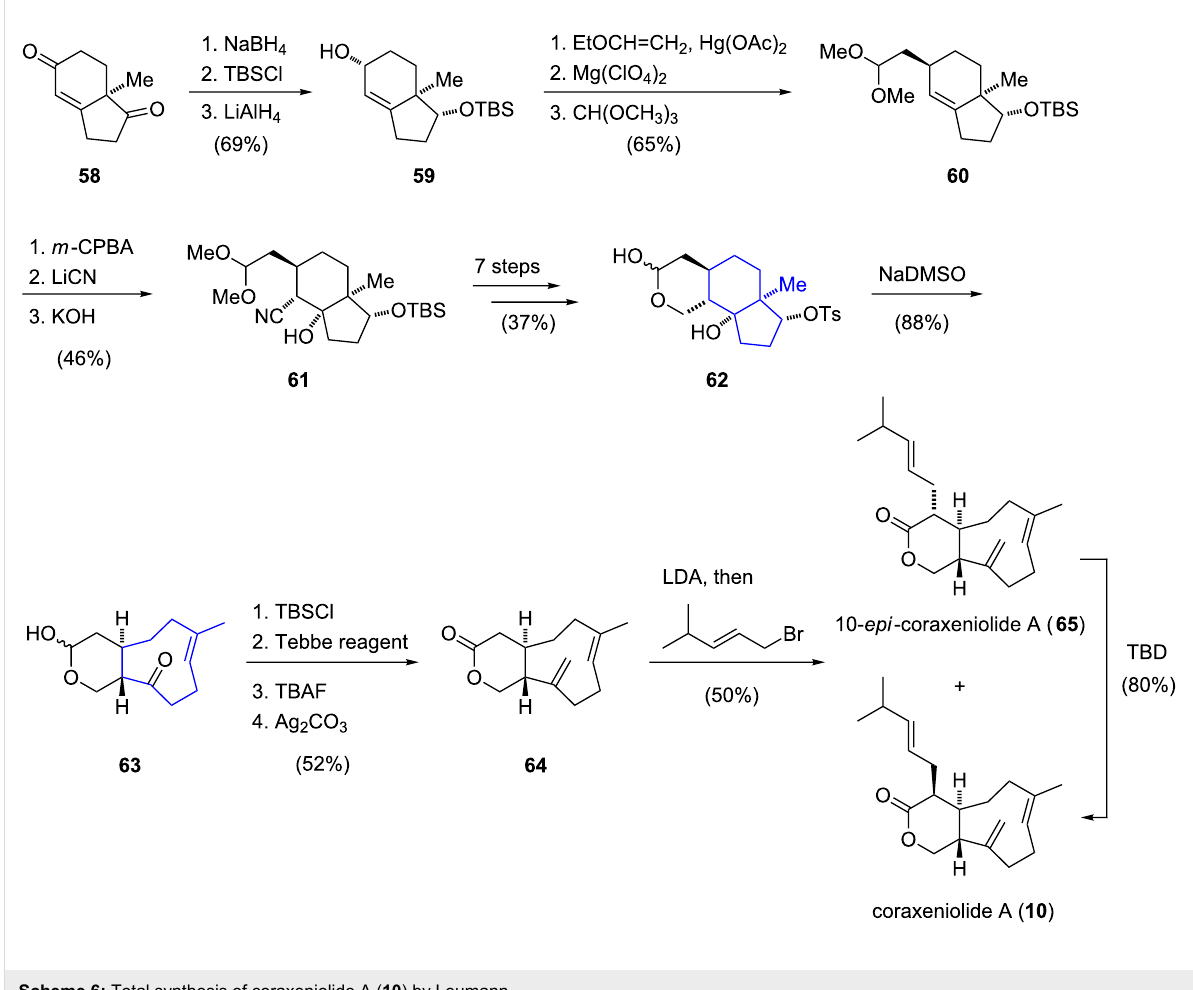
Scheme 6: Total synthesis of coraxeniolide A ( 10 ) by